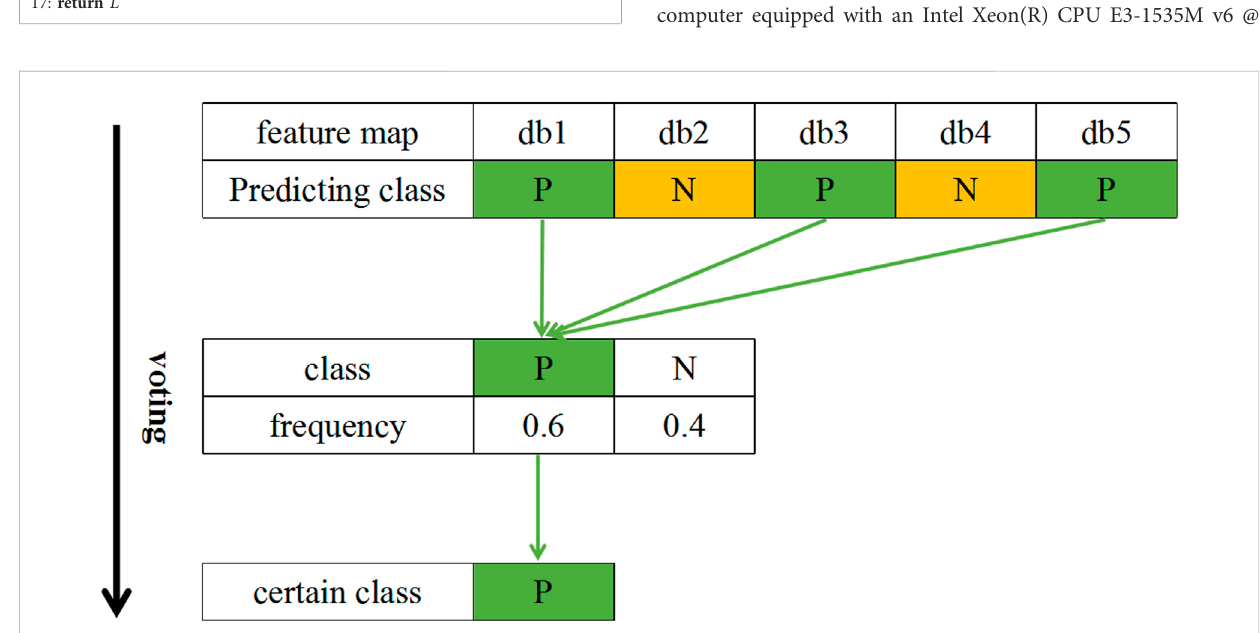
FIGURE 7 An example of the category voting process. Notes: P: Positive; N: